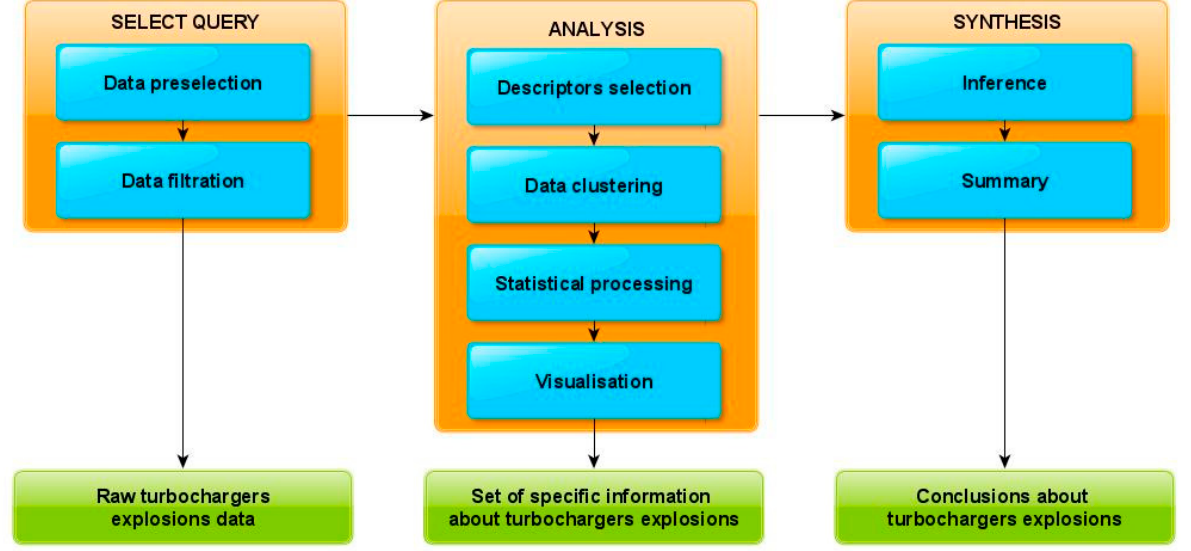
Figure 5. Methodology adopted in the study.